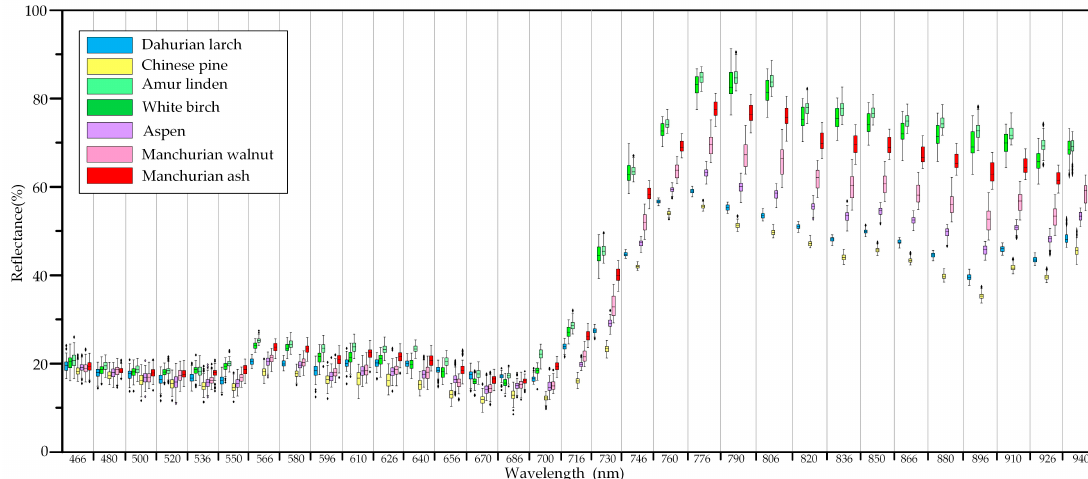
Figure 7. Boxplots of the reflectance of the 32 hyperspectral bands selected for the seven tree species analyzed. The midline of the box plot represents the median, and the hinges (end of the boxes) represent the 25th and 75th quartiles. The lines are drawn from each hinge to 1.5 times the spread (75th–25th quartile) or to the most extreme value (if smaller). Any point outside these values is represented as a circular point.